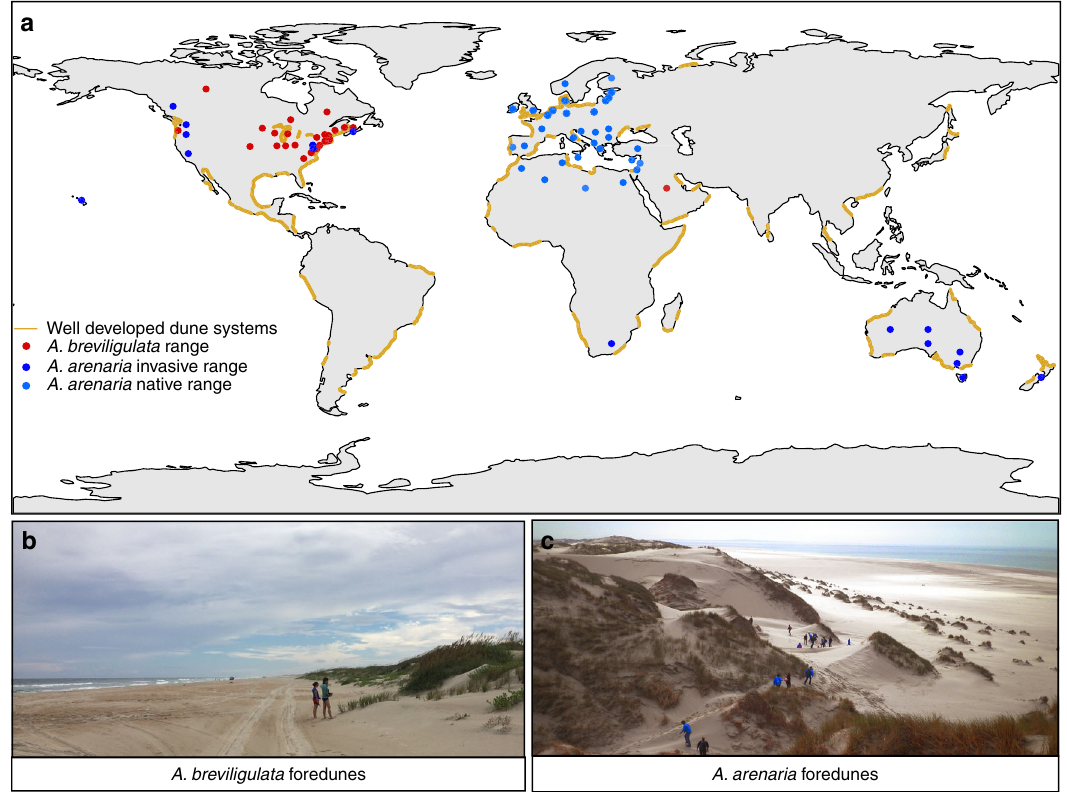
Fig. 1 Distribution and dune morphology of both Ammophila species. a map showing worldwide distribution of well-developed dune systems and the occurrence of both Ammophila species (adapted from refs. 22,58 ). b A typical low and wide foredune dominated by A. breviligulata (photo: V. Reijers), and c a typical tall and steep foredune dominated by A. arenaria (photo: N. van